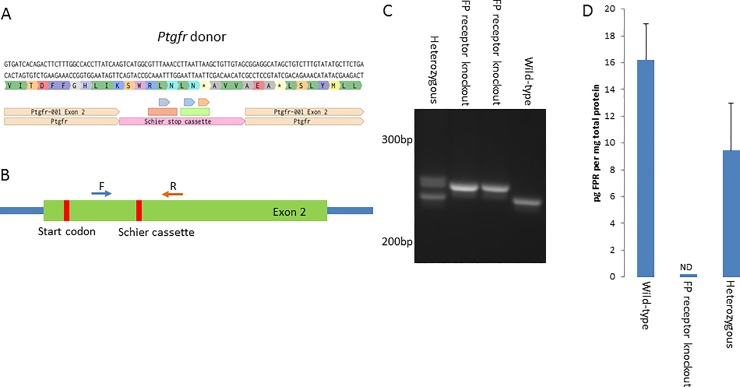
Generation of FP receptor knockout mice.A) Schematic representing strategy of Schier stop cassette insertion, single-guide RNA (sgRNA), WT Cas9 mRNA and a single-strand DNA (ssDNA) donor into the cytoplasm of C57BL/6NHsd zygotes. The ssDNA donors contained stop codons in all three reading frames to ensure a premature stop when inserted. B) Schematic representing Shier stop cassette. C) Genotyping data confirms insertion of the Schier stop cassette. D) ELISA in uterine tissue revealed diminished FP receptor expression at the protein level in mice heterozygous for the FP receptor compared to wild-type and non-detectible FP receptor expression in FP receptor knockout mice. ND = not detected. Error bars represent average ± standard deviation.